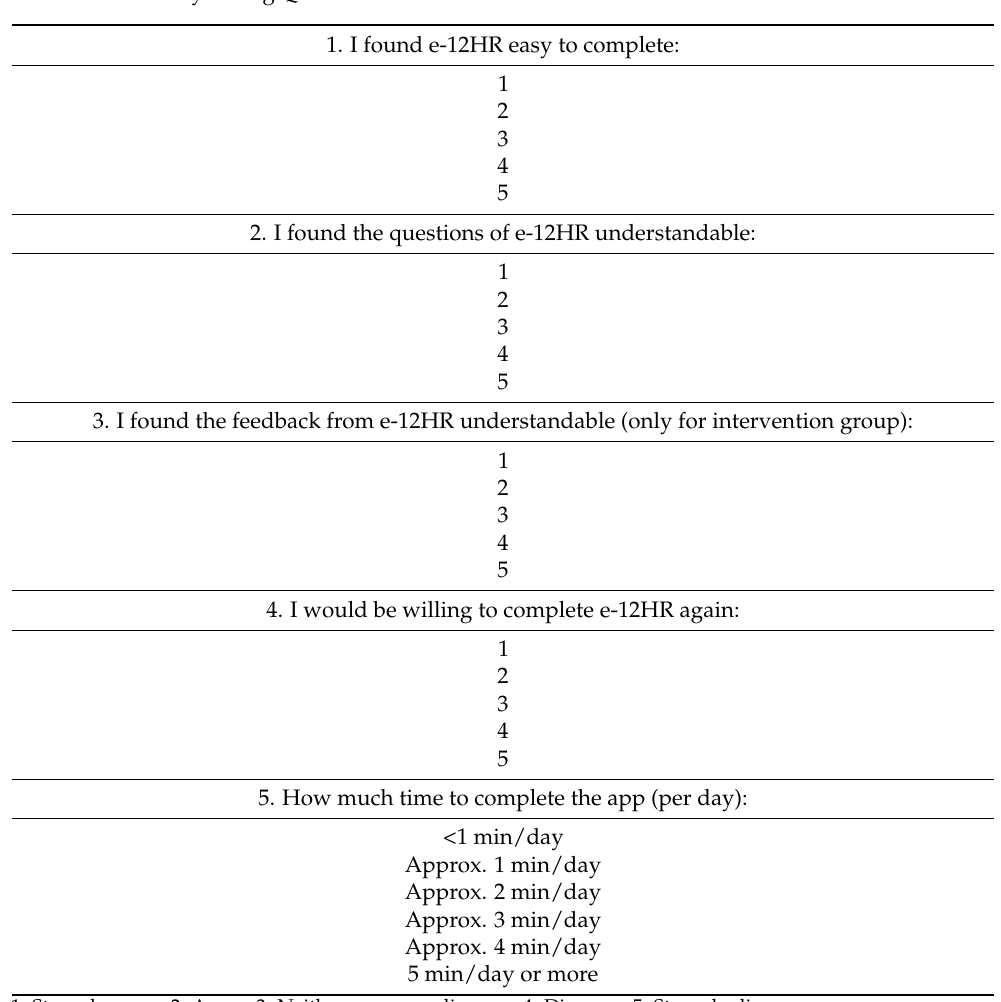
Table A1. Usability Rating Questionnaire for